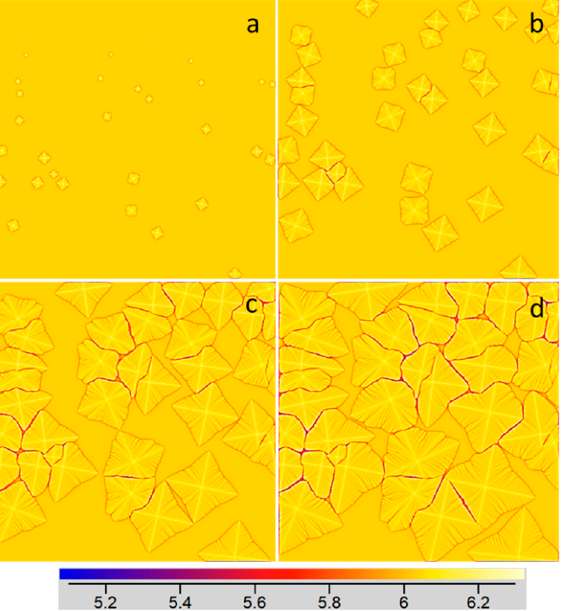
Figure 5. The grain growth with mass fraction of Fe is 0.9: ( a ) 0.3 s, ( b ) 0.8 s, ( c ) 1.5 s, ( d ) 2.0 s.